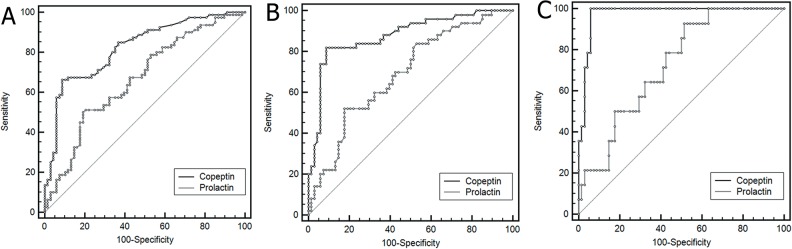
Receiver operating characteristic curves of serum copeptin and prolactin.(A) In controls (n = 69) and in children with febrile seizures irrespectively to the time of presentation (n = 83); (B) In controls (n = 69) and in children with febrile seizures presented <120 minutes since the event (n = 53); (C) In controls (n = 69) and in children with febrile seizures presented <60 minutes since the event (n = 14).